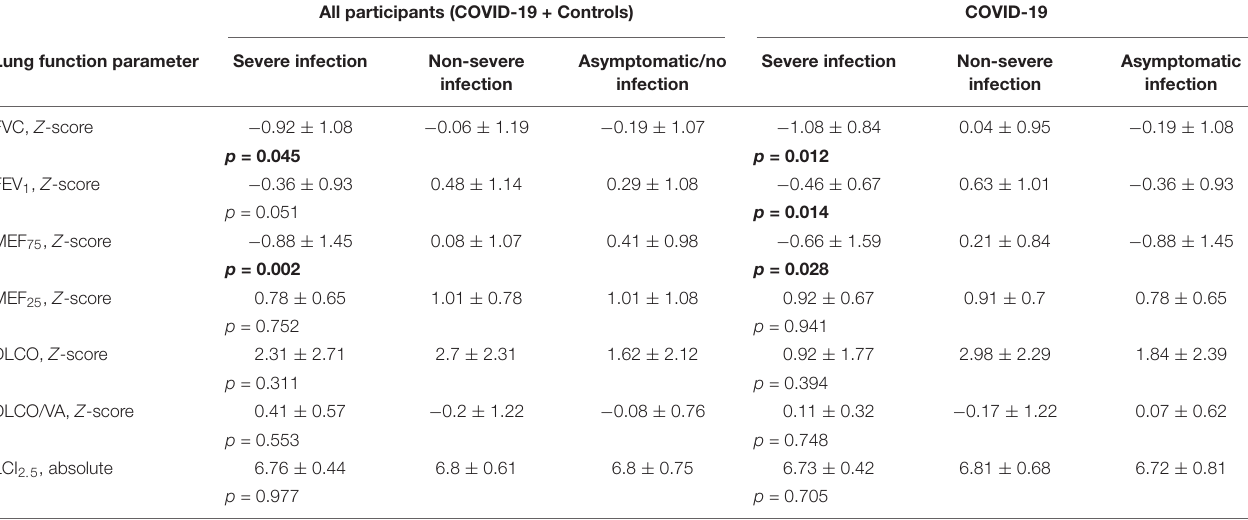
All participants (COVID-19 + Controls)